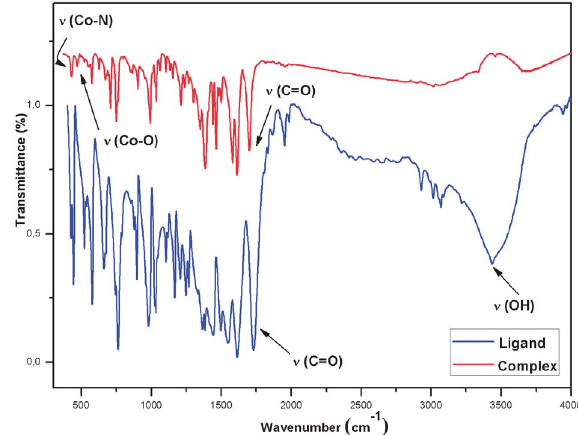
Figure 1. Comparison of the two IR spectra of the complex and li-